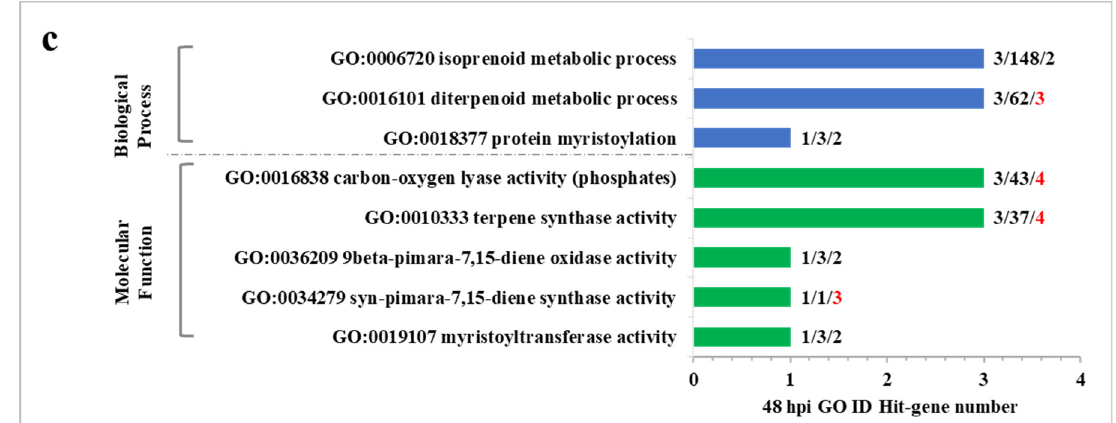
Figure 3. WT-vs-MT: GO enrichment significance analysis ( p < 0.01). ( a ) 12 hpi GO enrichment significance analysis. ( b ) 24 hpi GO enrichment significance analysis. ( c ) 48 hpi GO enrichment significance analysis. The tag represents Hit_Gene number/background Gene number/ − log10( p ). The red font represents the GO term with prominent significance.